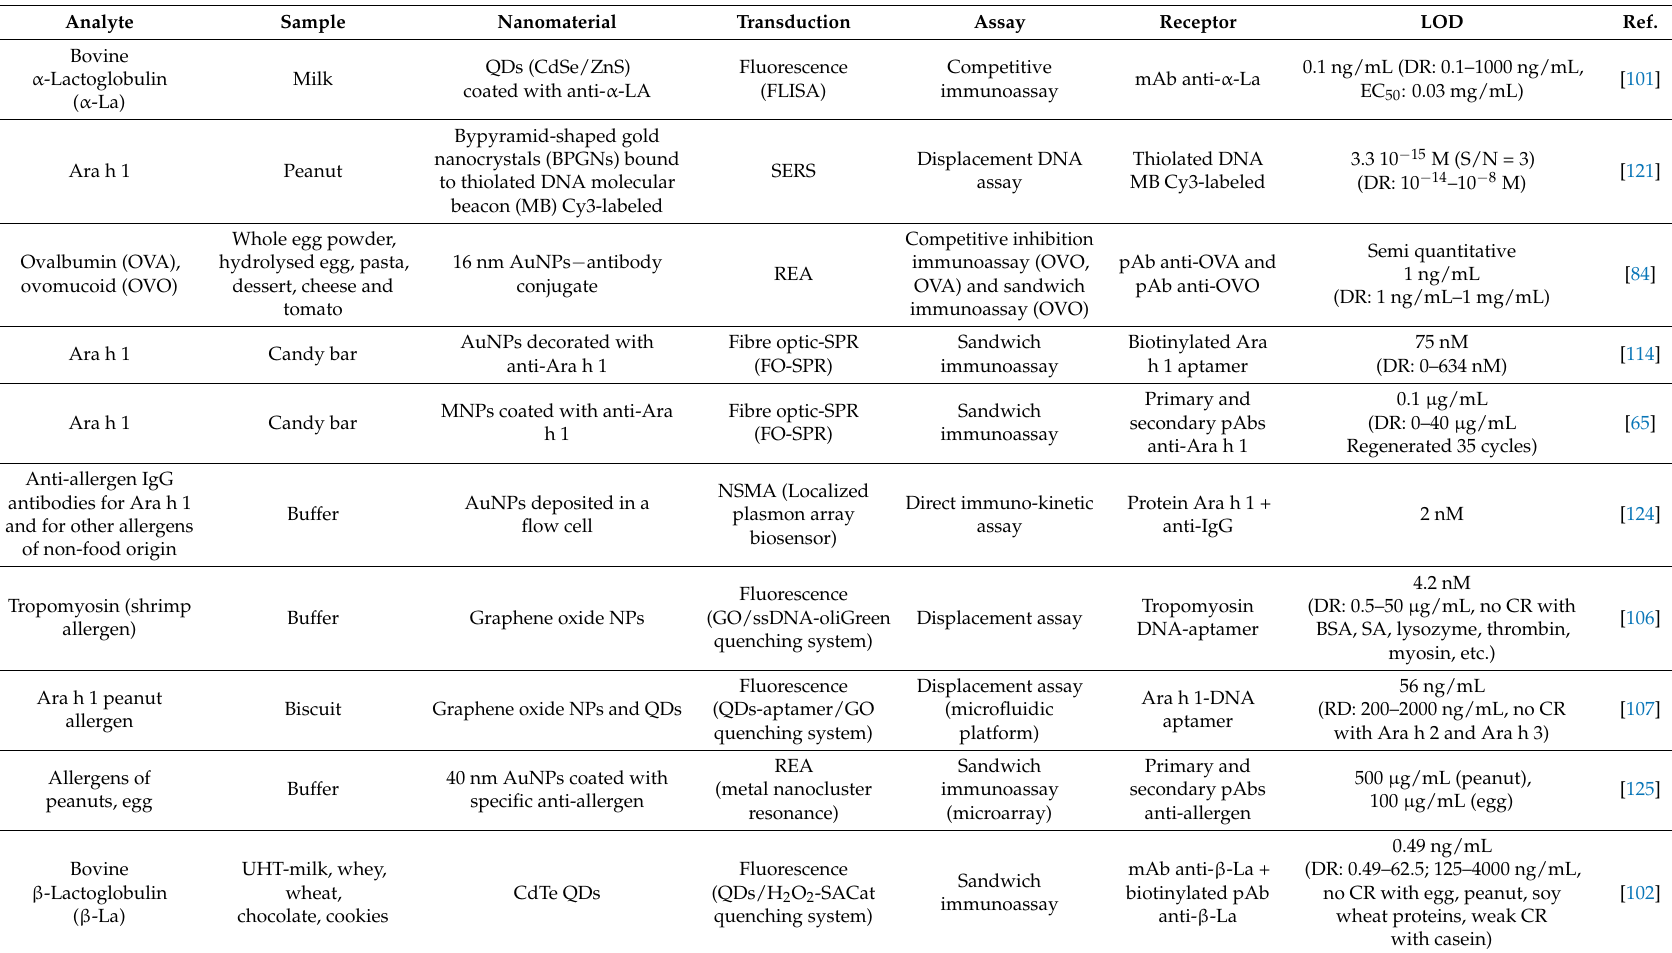
Table 6. Fluorescence, surface-enhanced Raman scattering (SERS) and other optical-based bioassays for the detection of food allergens using